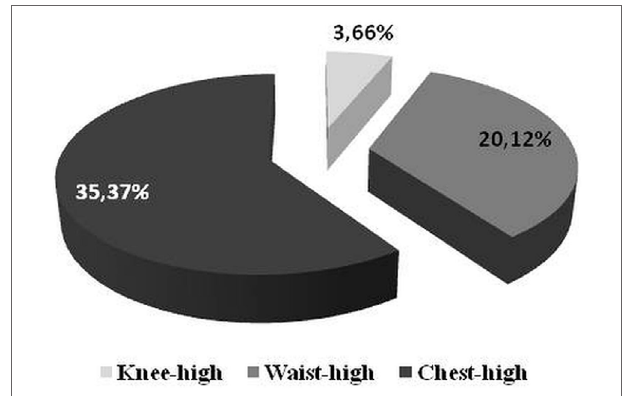
FigUre 2 | Percentage distribution of prevailing answers from Figure 1